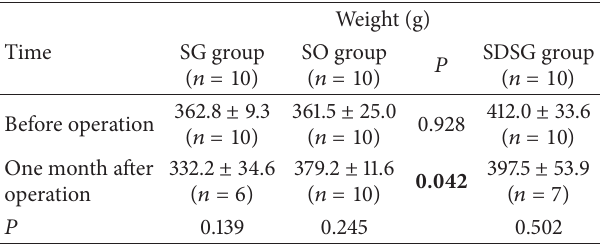
Table 1: Changes of rat’s body weight among groups. Sleeve gastrectomy group (SG), sham-operation group (SO), and sleeve gastrectomy of SD rats group (SDSG).